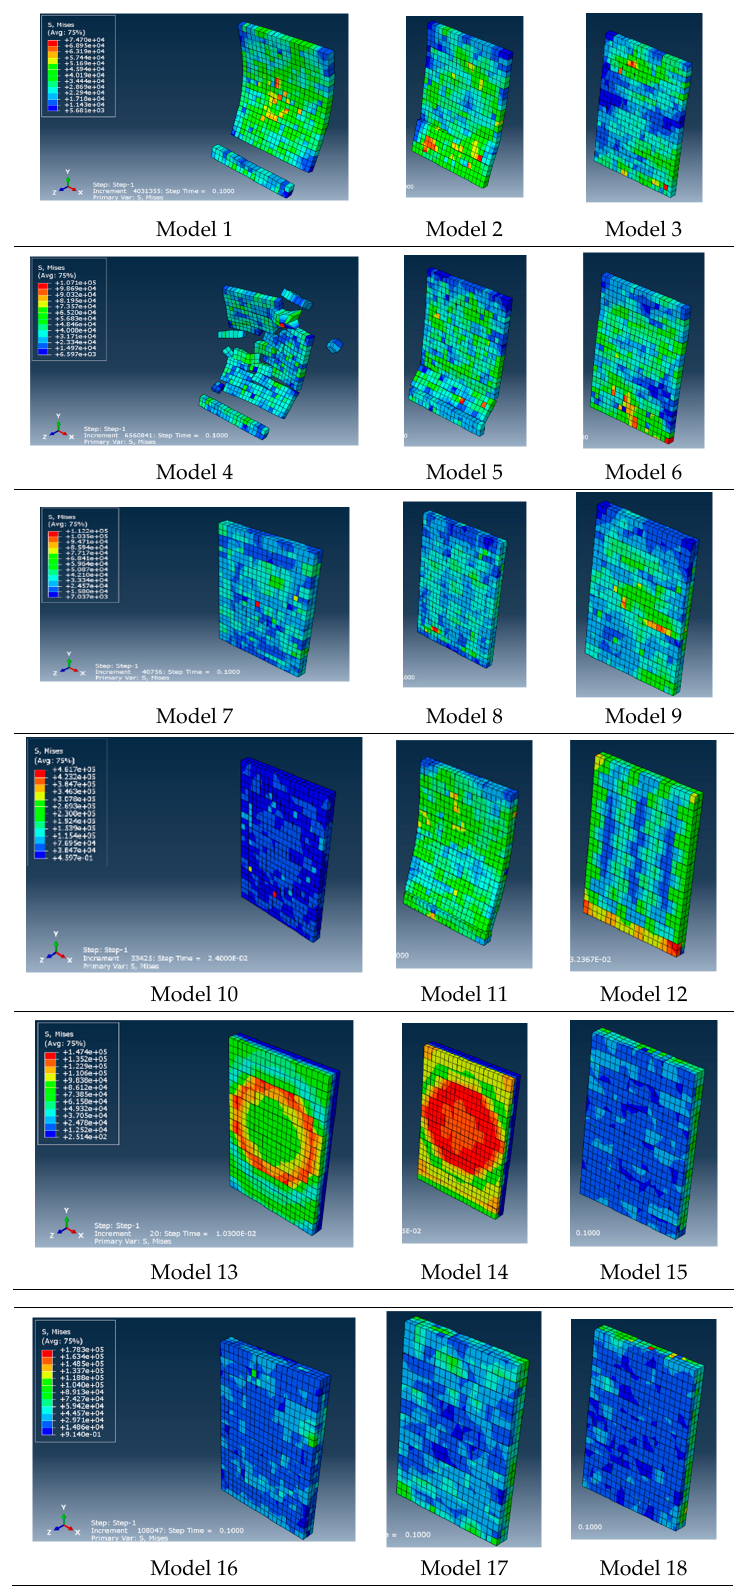
Figure 9. The von Mises stress distribution in some of the simulated wall models.